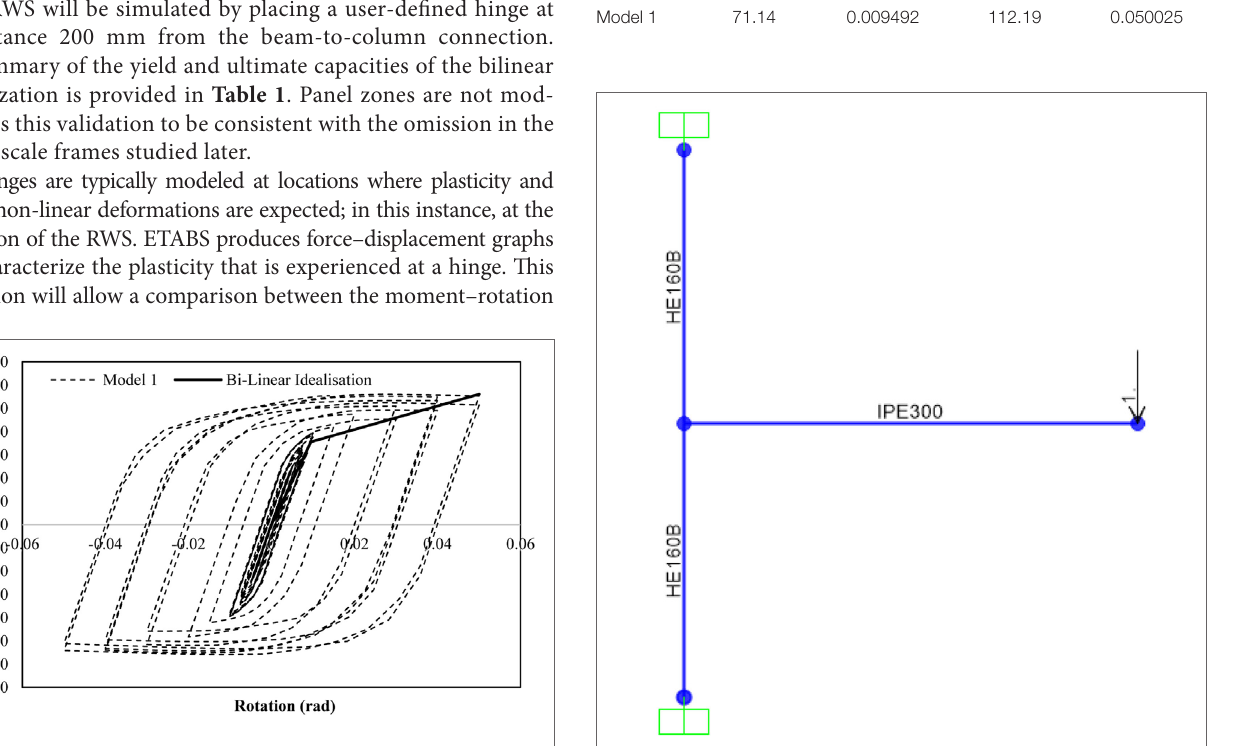
Figure 2 | Hysteretic moment-rotation curve for Model 1 (Tsavdaridis and Papadopoulos, 2016). Figure 3 | Beam-to-column configuration modeled in